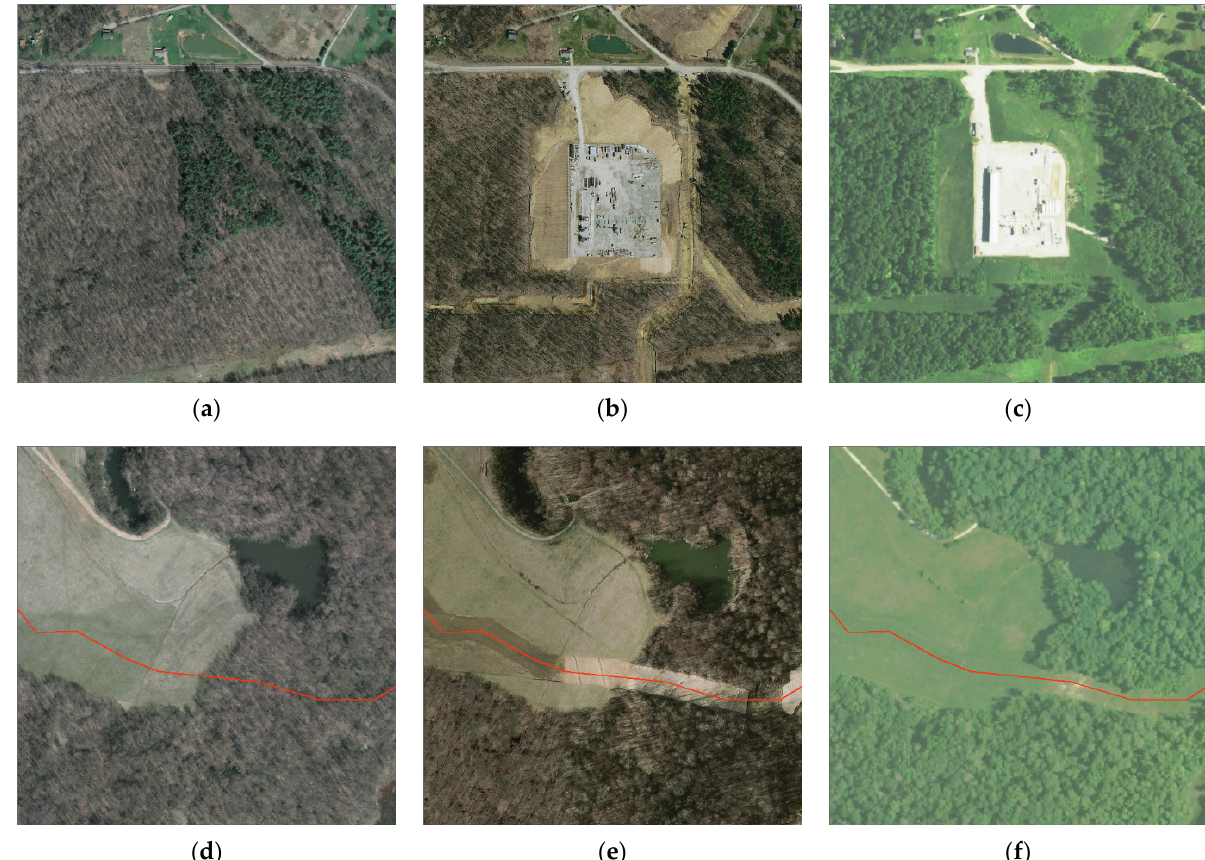
Figure 5. The construction of a well pad and pipeline ROW corridor: ( a ) before the construction of a well pad, 2006; ( b ) during the construction of a well pad, 2014; ( c ) after the construction of a well pad, 2017; ( d ) before the construction of a pipeline ROW corridor, 2006; ( e ) during the construction of a pipeline ROW corridor, 2014; ( f ) after the construction of a pipeline ROW corridor, 2017. Aerial images were collected from OSIP and NAIP.